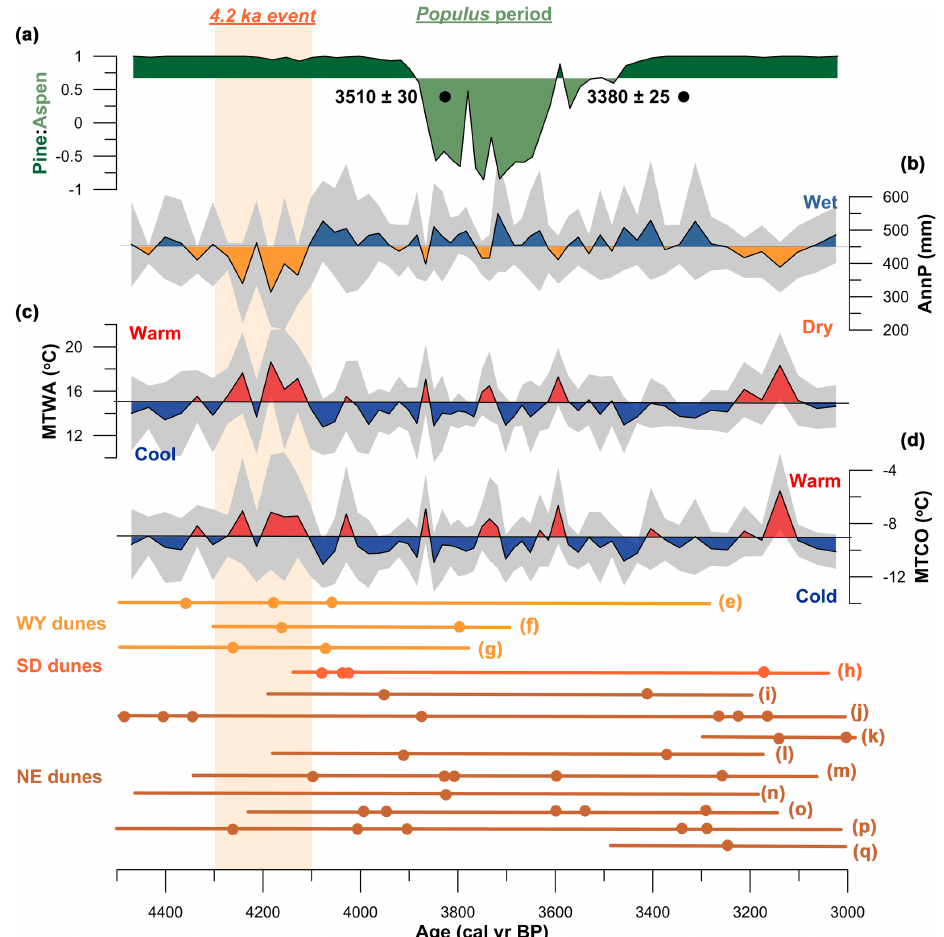
Figure 1. Regional paleo-proxy evidence supporting drought conditions between ∼ 4200 and ∼ 4000calyrBP. (a) Pine:Aspen pollen ratio showing the Populus period – a change from a lodgepole-pine-dominated forest to a mixed forest of lodgepole pine and quaking aspen – from Long Lake, southeastern Wyoming (Carter et al., 2013). Black circles illustrate radiocarbon dates that were used to temporally constrain the Populus period; (b–d) Reconstructed climate variables from Long Lake, southeastern Wyoming – annual precipitation (AnnP), mean temperature of the warmest month (MTWA); mean temperature of the coldest month (MTCO) (Carter et al., 2017a); (e–q) clusters of radiocarbon and luminescence dates from regional sand dunes – age data error bars reflect those reported by the original authors, typically 1 to 2 σ ; (e) Ferris dunes, Wyoming (Stokes and Gaylord, 1993); (f–g) Casper dunes, Wyoming (Halfen et al., 2010); (h) White River Badlands dunes, South Dakota (Rawling et al., 2003); (i) Nebraska Hills dunes, Nebraska (Schmieder et al., 2011); (j) Nebraska Hills dunes (Miao et al., 2007); (k–l) Nebraska Hills dunes (Mason et al., 2004); (m) Nebraska Hills dunes (Goble et al., 2004); (n) Nebraska Hills dunes (Stokes and Swinehart, 1997); (o) Nebraska Hills dunes (Loope et al., 1995); (p) Nebraska Hills dunes (Ahlbrandt et al., 1983); (q) Nebraska Hills dunes (Madole, 1995). Orange shading denotes the 4.2ka drought. Data were modified from Carter et al. (2013, 2017a), and Halfen and Johnson